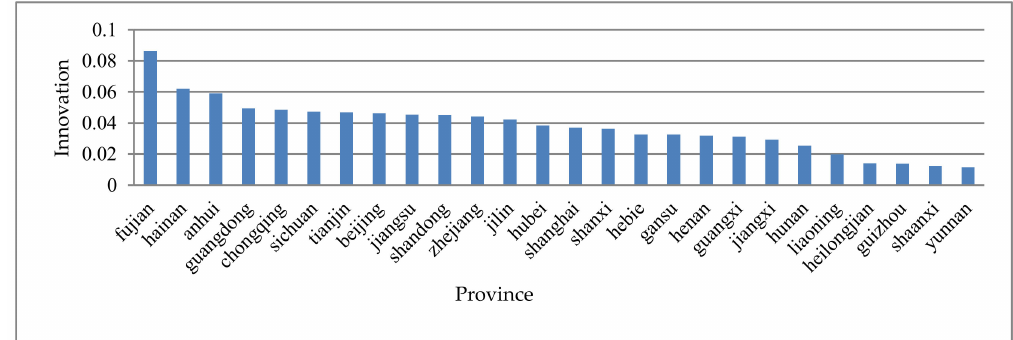
Figure 1. Innovation ranking of 26 provinces. Weighted average of innovation data of all medical enterprises in the province during the sample period is the innovation level of the province. This paper excludes the data of Neimenggu, Qinghai, Xinjiang, Ningxia, Xizang, Taiwan, Hong Kong, and